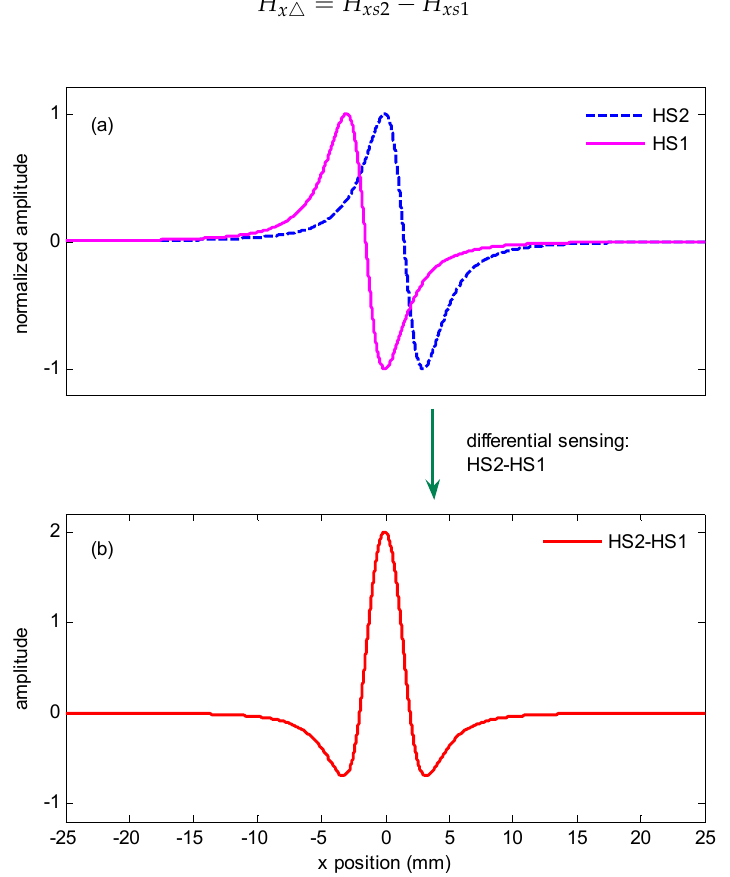
Figure 4. Signals of differential sensing strategy. ( a ) normalized signals on each sensors with a liftoff 2.5 mm and test line width 1 mm; ( b ) differential signal H s 2 − H s 1